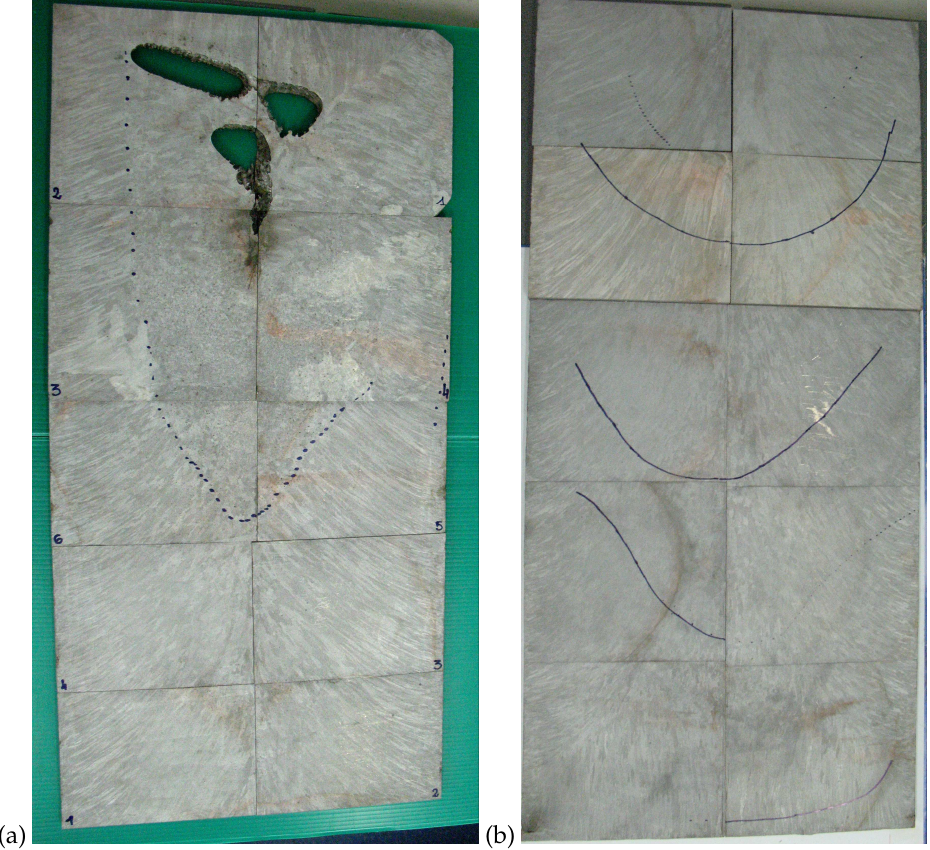
Figure 10. Metallurgical structure revealed on an axial section of the ingot. (( a ): top part—( b ): bottom